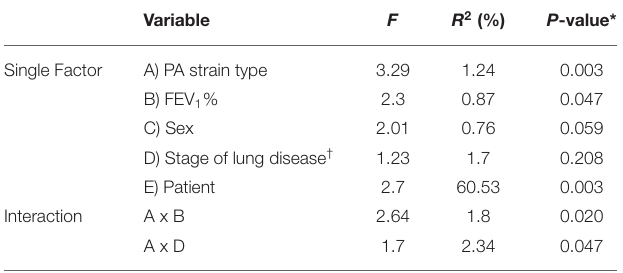
TABLE 2 | CF bacterial community structure variation explained by various factors and their interactions based on Bray-Curtis distances using the accessory microbiome data set.